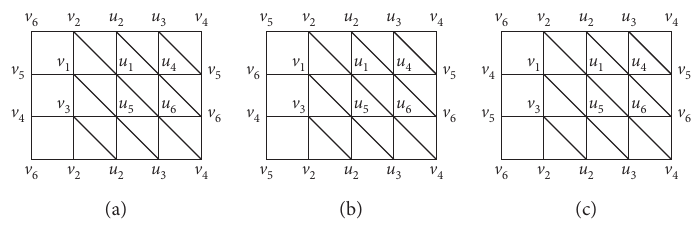
Figure 4: Doubly semiequivelar maps on torus and Klein bottle of type [ 3 6 : 3 3 , 4 2 ] [3 6 : 3 3 , 4 2 ] 2